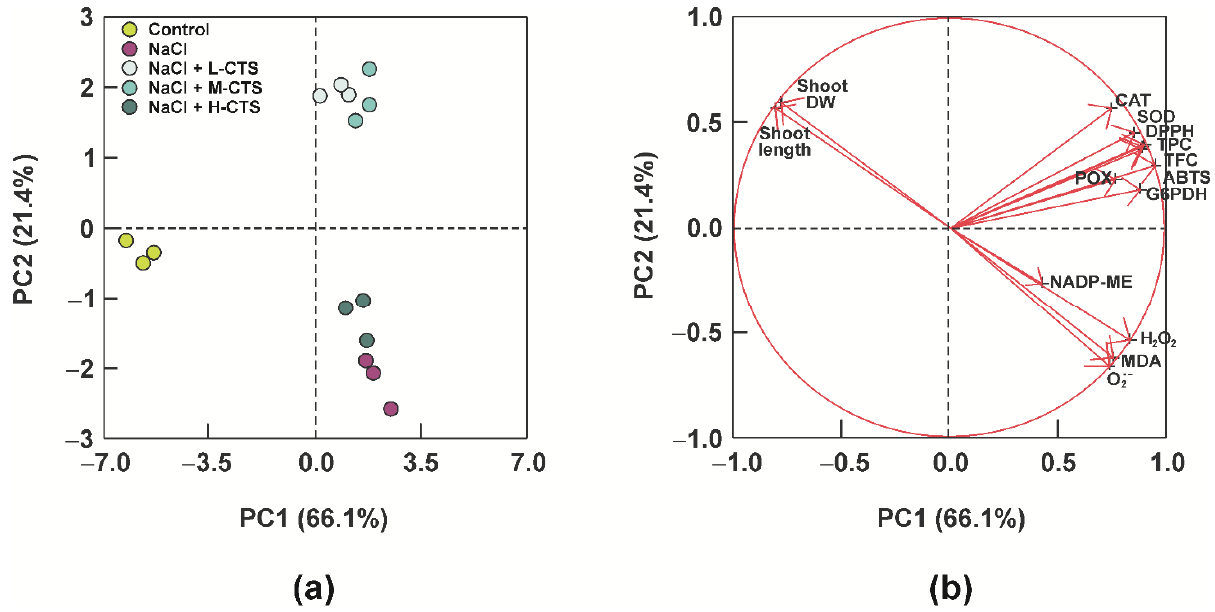
Figure 5. Principal component analysis ( a ) score plot and ( b ) loading plot for the traits analyzed in the shoot of durum wheat seedlings as function of the different treatments. The percentages of total variance represented by principal component 1 (PC1) and principal component 2 (PC2) are shown in parentheses. In ( a ), colored symbols correspond to the five treatments imposed on durum wheat seedlings. In ( b ), vectors indicate the direction and strength of each variable to the overall distribution.